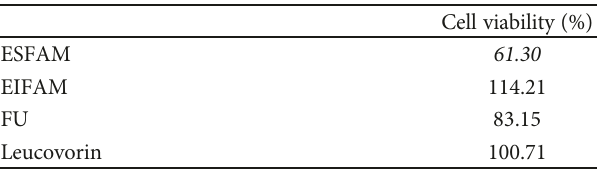
Table 1: Result of cell viability assay using MTT assay in percentage. This showed that ESFAM extract has the best result compared to